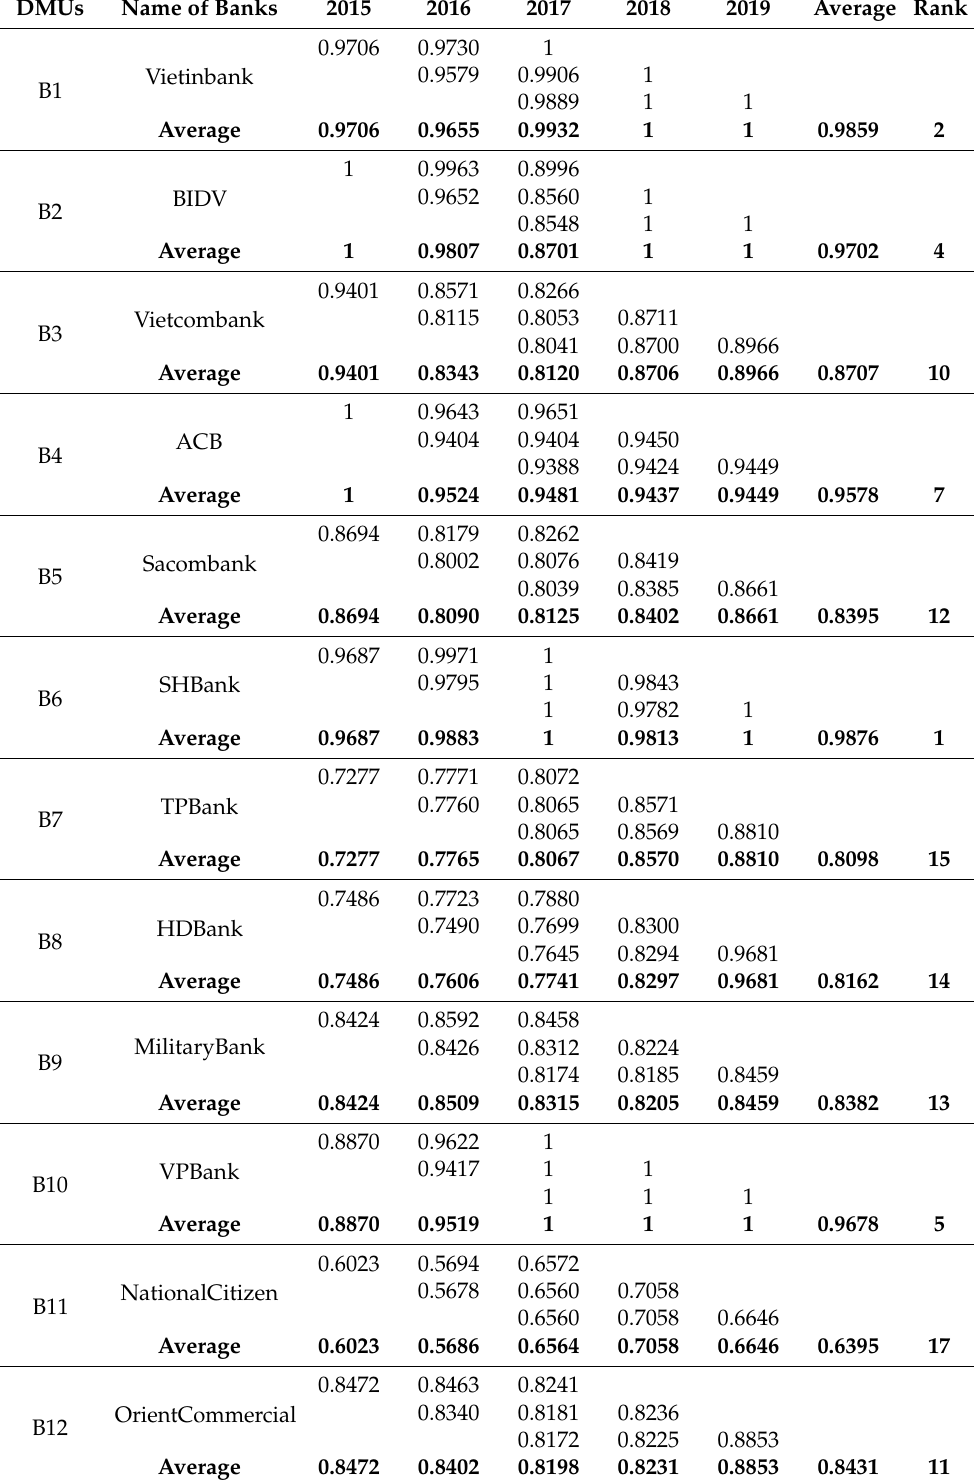
Table 9. The Window results for a 3-year